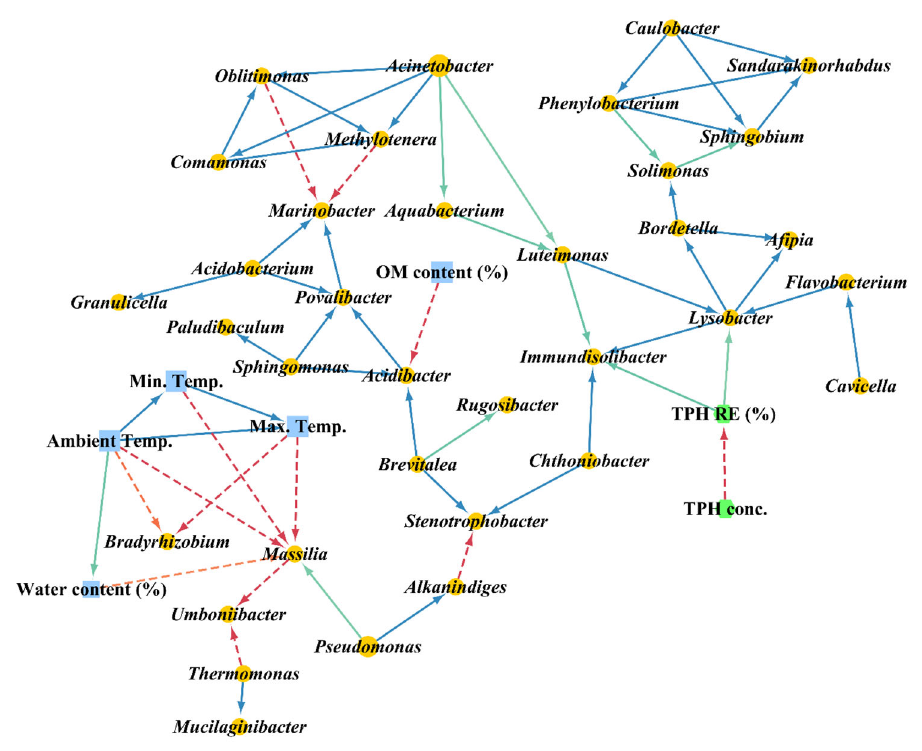
Figure 5. Association network analysis between the environmental conditions, pollutant concentrations, and bacterial genera. Solid (blue and green) and dashed (red) edges indicate positive and negative relationships, respectively ( p < 0.005).